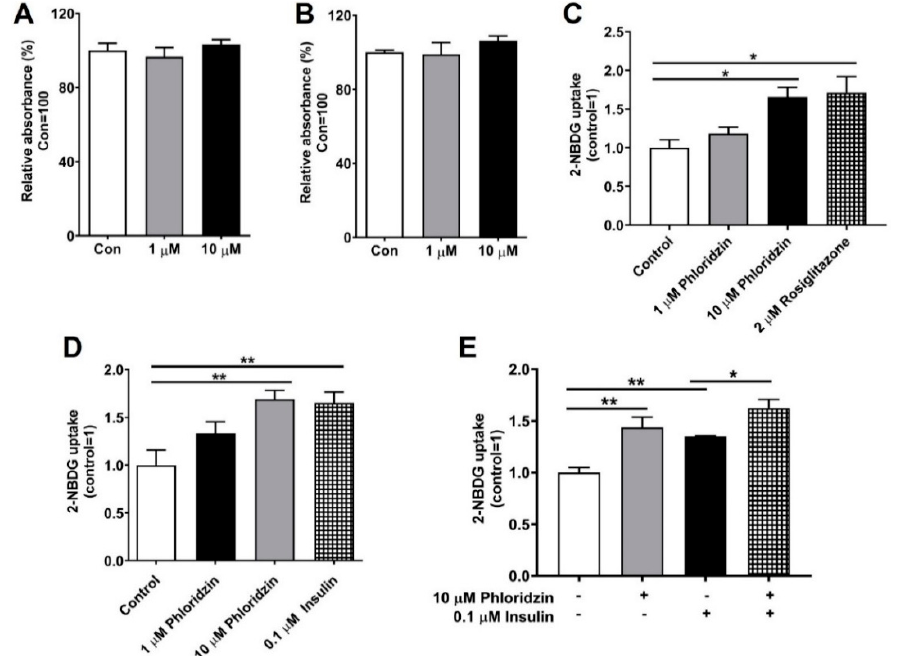
Figure 4. Phloridzin increases glucose uptake. ( A , B ) 3T3-L1 adipocytes ( A ) and C2C12 muscle cells ( B ) were incubated with the indicated concentrations of phloridzin for 2 days and cell viability was assessed by the EZ-Cytox assay kit. ( C – E ) Differentiated 3T3-L1 preadipocytes ( C ) and C2C12 muscle cells ( D , E ) were incubated for 1 h or 72 h ( E ) with 1 or 10 μ M phloridzin, 0.1 μ M insulin, or 2 μ M rosiglitazone, and then treated with the fluorescent glucose indicator, 2-NBDG, for 30 min. For the detection of 2-NBDG, cells were washed with PBS and the fluorescence intensity was evaluated using a fluorescence microplate reader. All experiments were independently repeated at 3 times. Results are expressed as mean ± SEM. Data were analyzed using a two-tailed unpaired t -test. ** p < 0.01, * p < 0.05 compared to the control